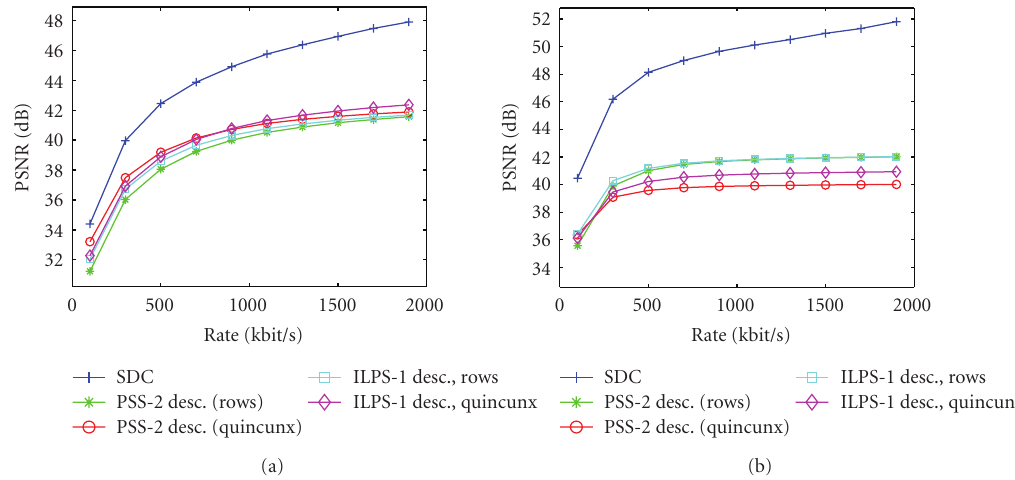
Figure 6: Performance of color view, two subsequences received. (a) Breakdance. (b)